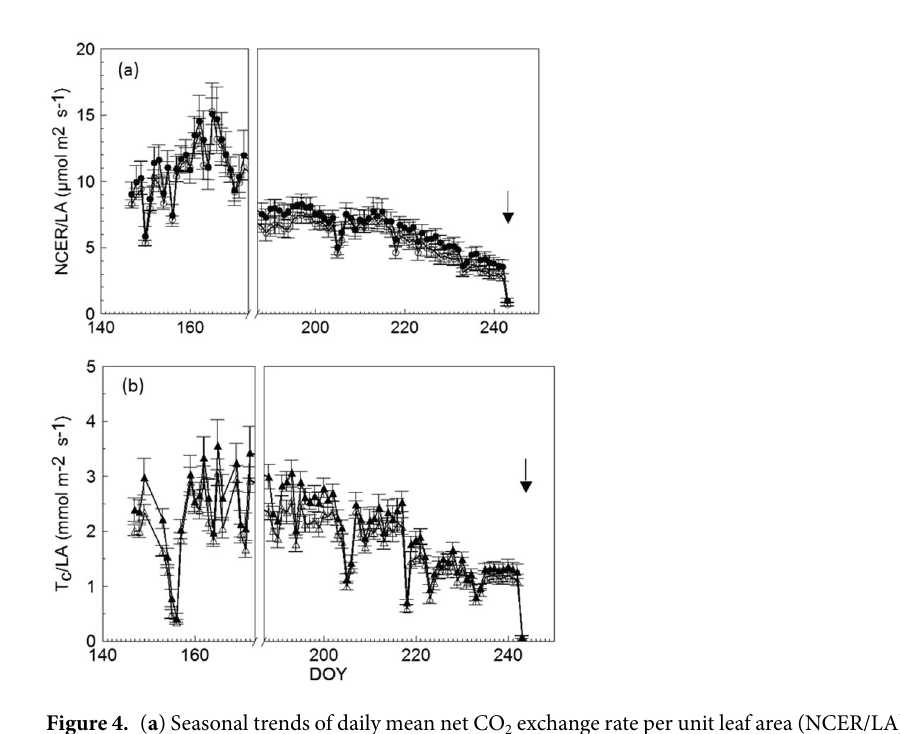
Figure 3. ( a ) Seasonal trends of direct ( ● ) and diffuse ( ○ ) photosynthetically active radiation (PAR) and air vapor pressure deficit (VPD); ( b ) inlet chamber air temperature ( ◻ ), outlet chambers air temperature for PS-SG ( ● ), outlet chambers air temperature for Accession 72-096 ( ○ and ambient CO 2 concentration ( ▵ ) measured at the trial site. Values are daily means averaged from dawn to dusk.